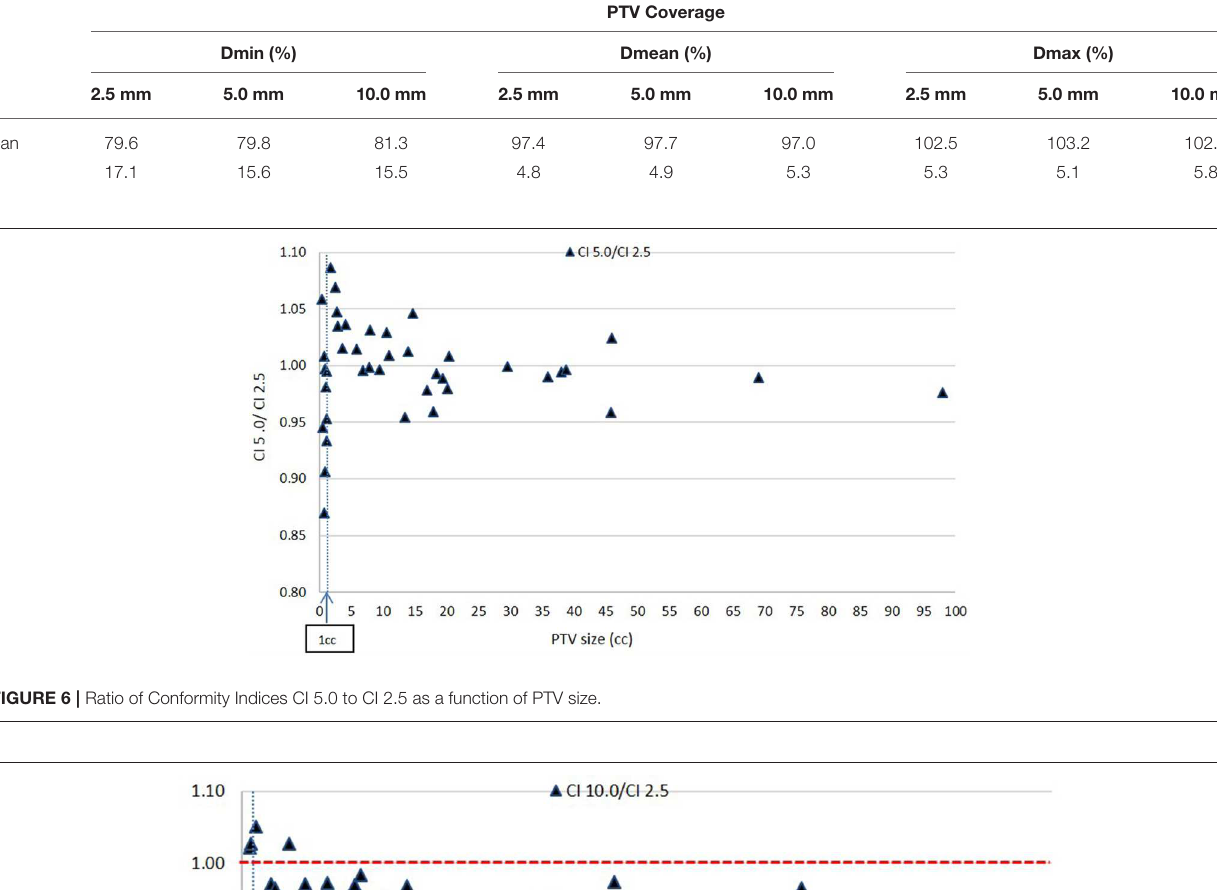
TABLE 2 | PTV coverage for each of the three MLC leaf sizes.